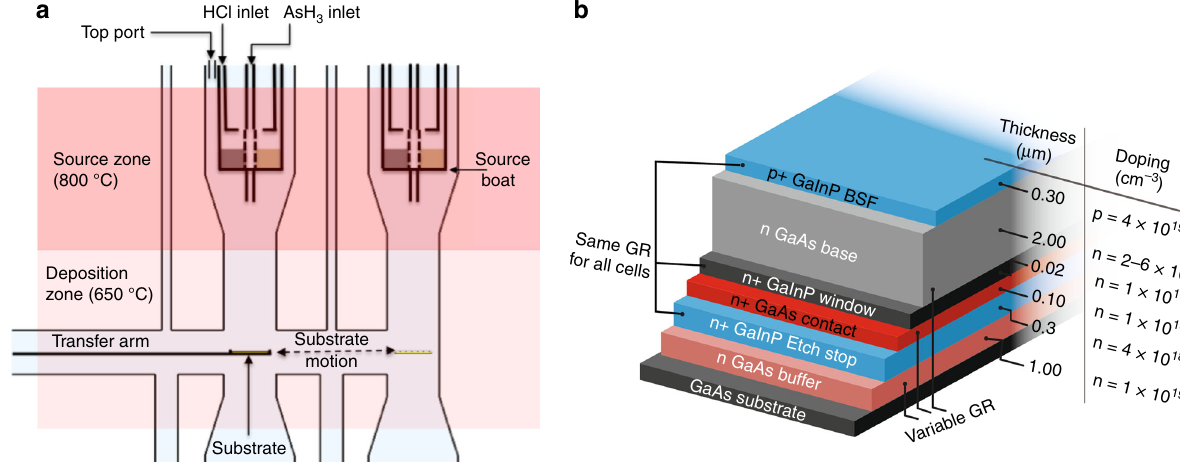
Fig. 1 Schematics of D-HVPE reactor and GaAs solar cell. a Simpli fi ed schematic of the dual-chamber D-HVPE reactor used in this study. b Targeted device structure, grown in an inverted con fi guration, of the GaAs rear-heterojunction solar cells used in this study, identifying the layers in which the growth rate was